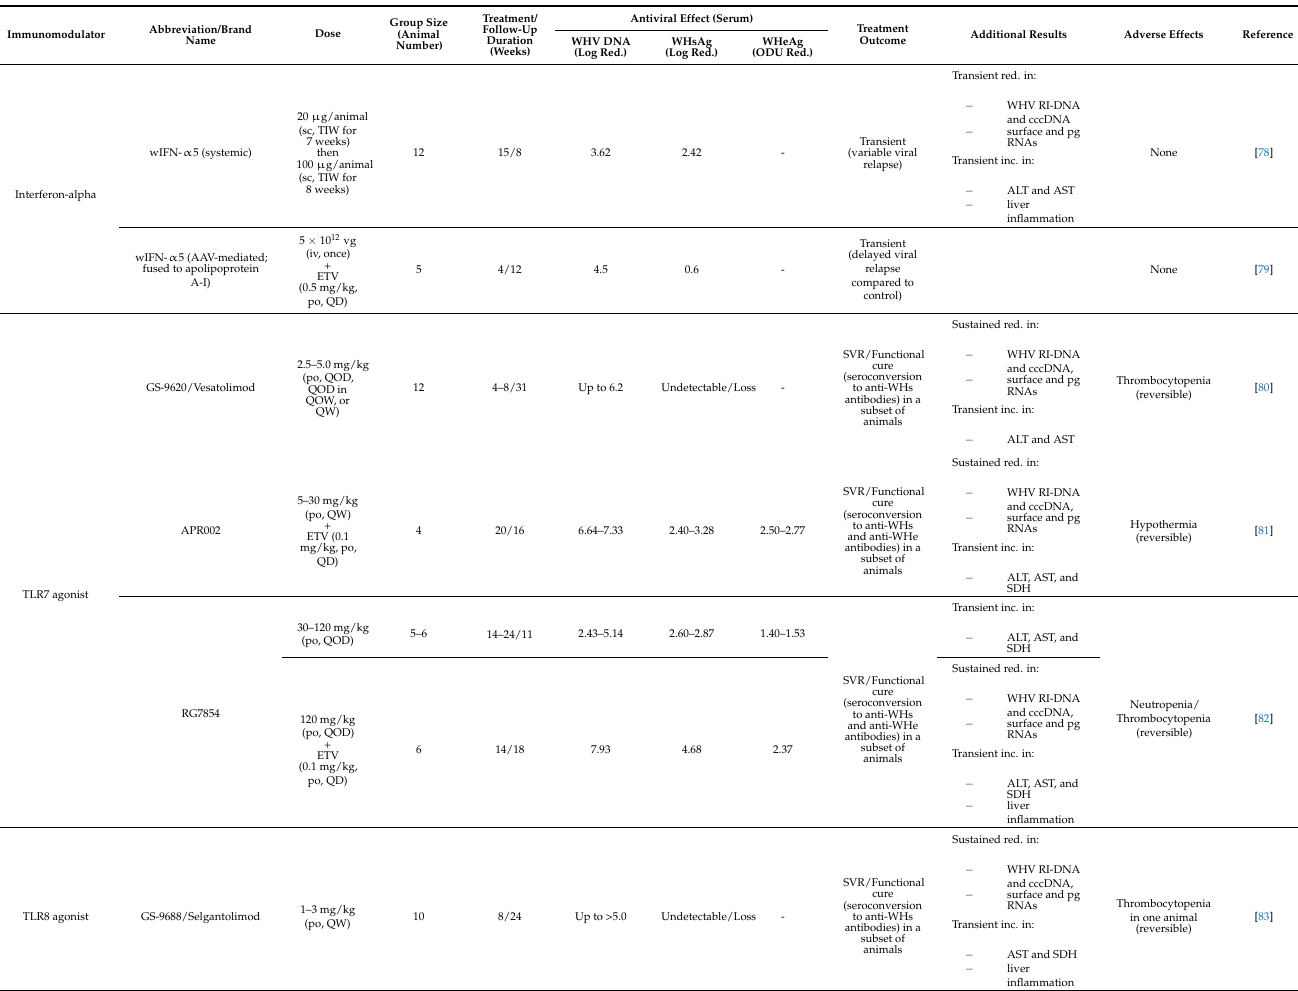
Table 2. Immunomodulators recently evaluated in the woodchuck for safety and antiviral efficacy against